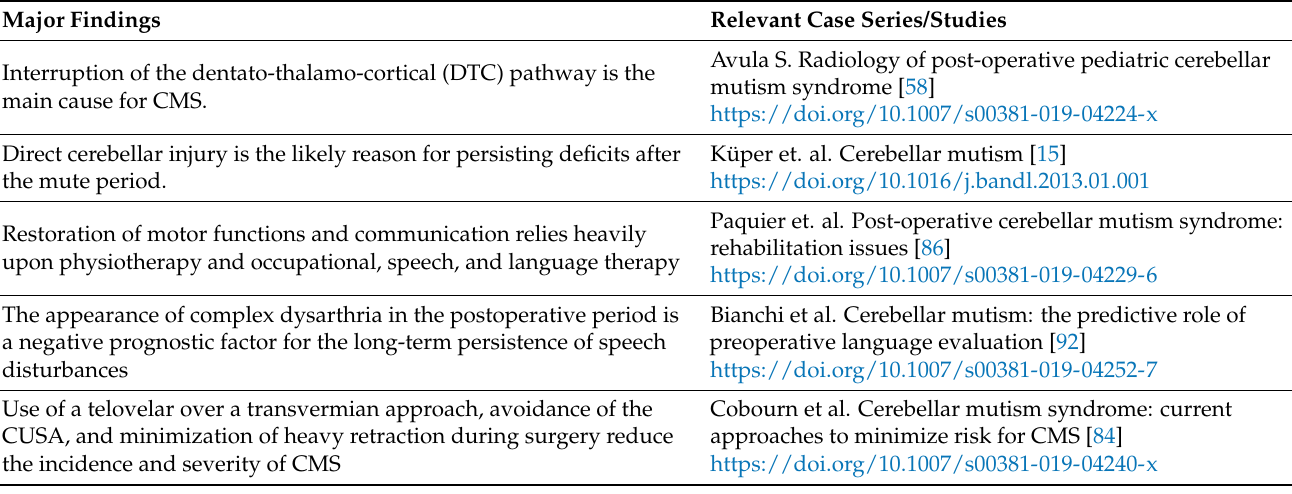
Table 1. Pivot table, incorporating all relevant major findings of previous case series/studies, relevant with